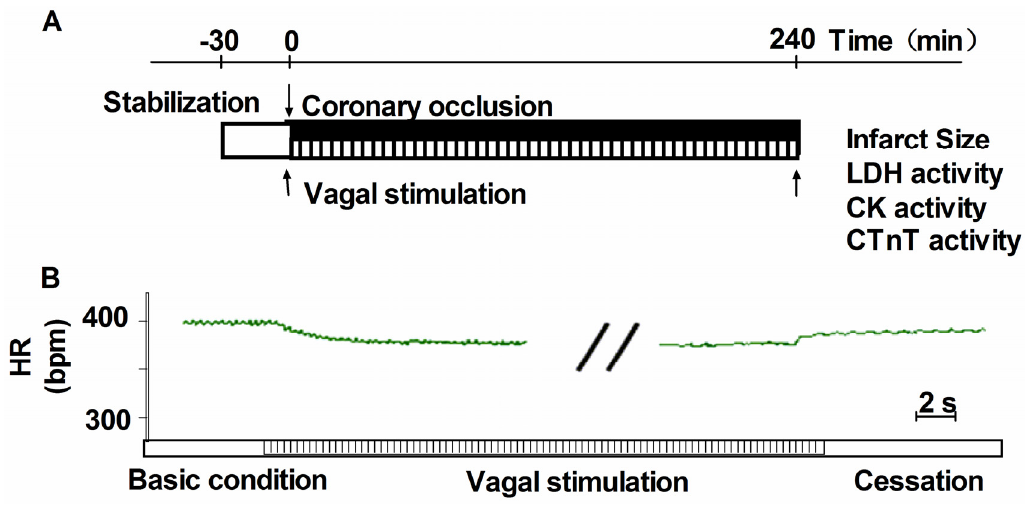
Figure 7. Schematic representation of the protocol and changes in HR with